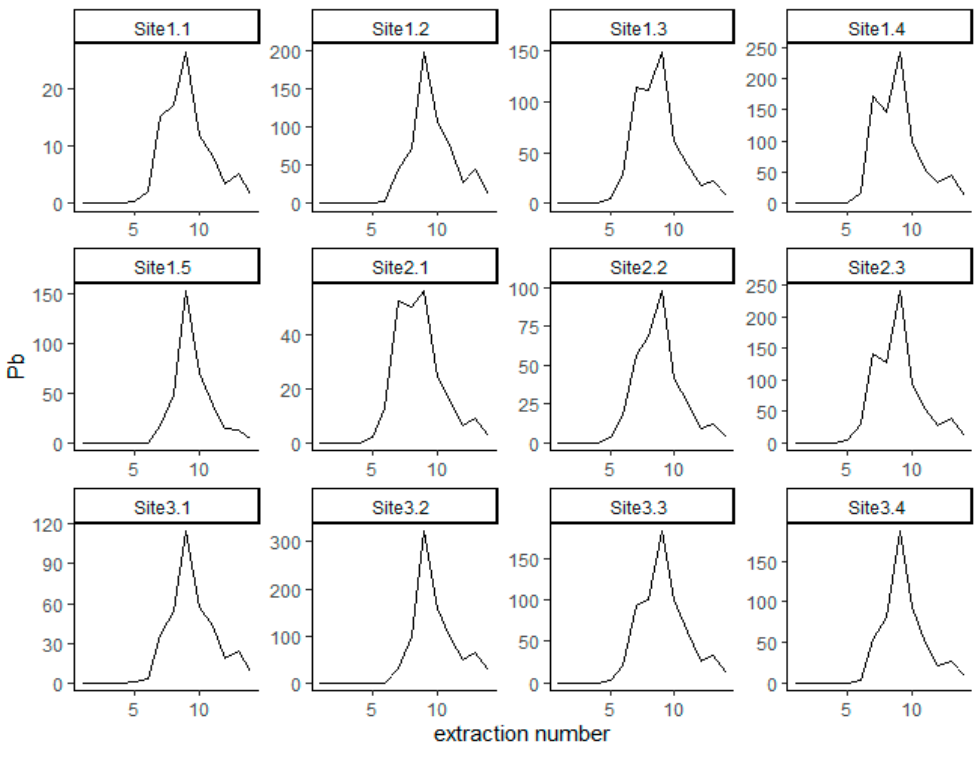
− 1 . Geosciences 2020 , X , x FOR PEER REVIEW